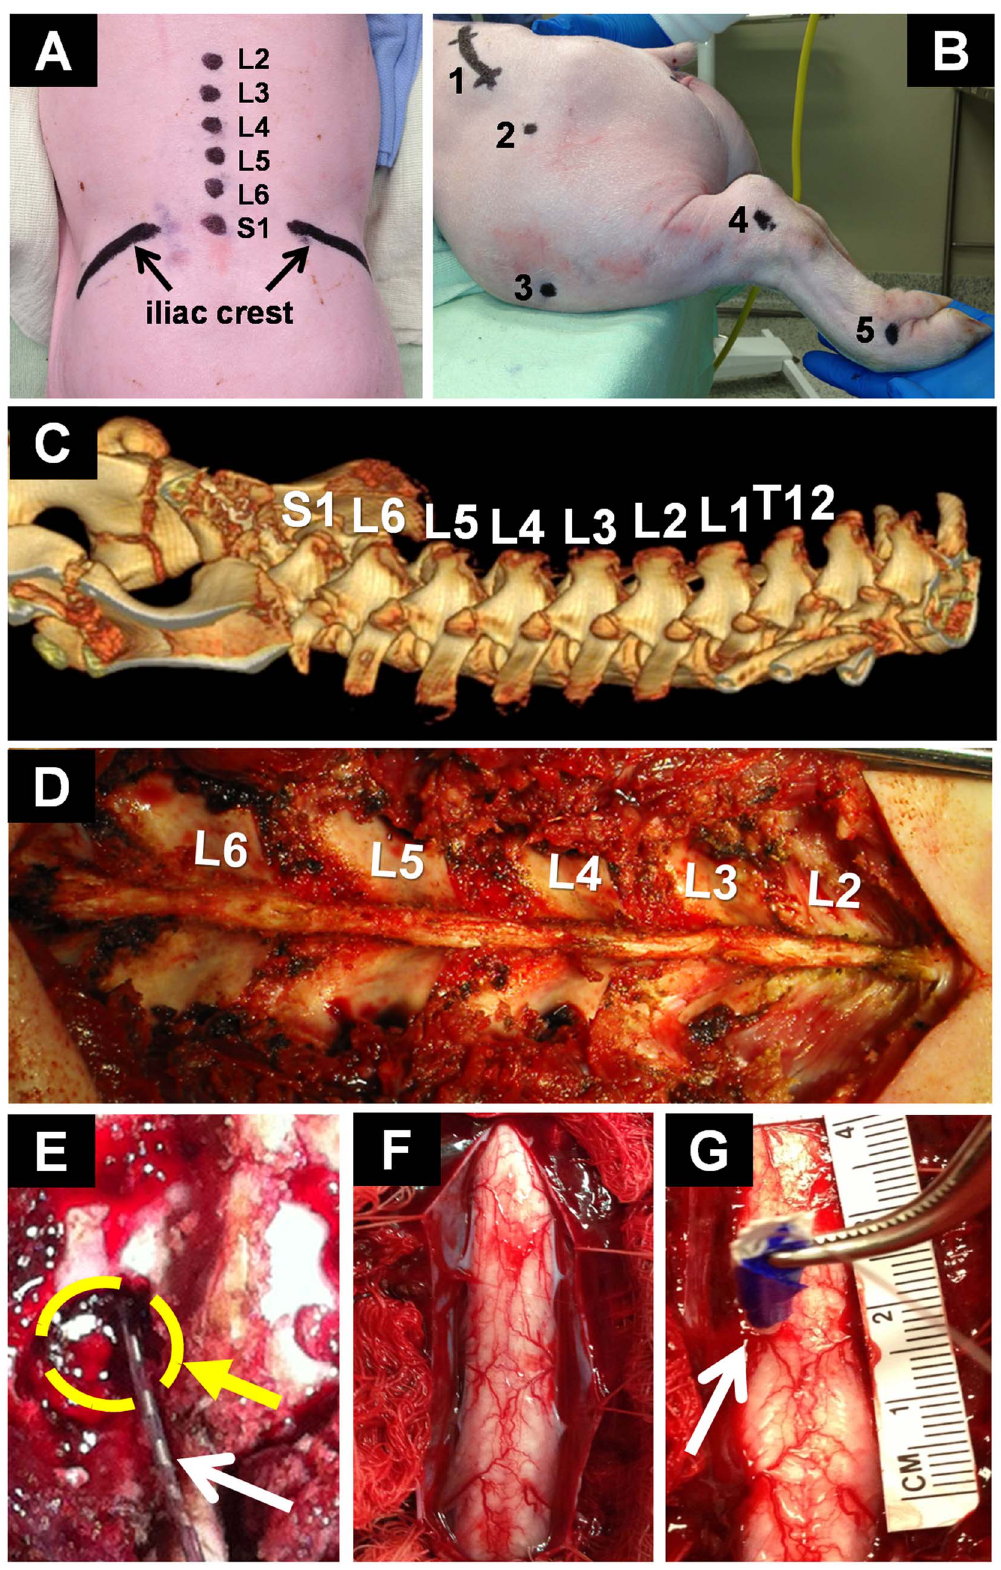
Figure 1. Experimental setup. ( A ) Anatomical landmarks (i.e., sacrum, iliac crest, and spinous processes) for localization of the lumbar spine (L2– S1); ( B ) Lateral view of anatomical motion analysis markers (1-Lateral iliac crest, 2-Trochanter major, 3-Patella, 4-Lateral malleolus, 5-Fourth metatarsal); ( C ) Pre-operative computed tomography: Lower thoracic vertebrae, lumbar vertebrae and sacrum; ( D ) Exposure of the lumbar spine; ( E ) Laminotomy at L5-left (circle) and epidural electrode (arrow); ( F ) Exposure of the spinal cord for intraspinal microstimulation; ( G ) Typical